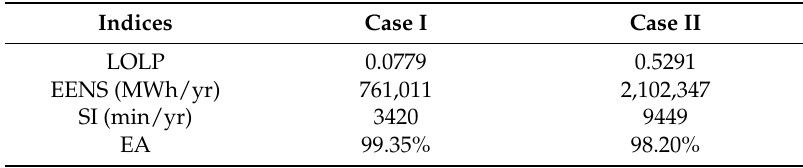
Table 6. Reliability indices of test grid with a different number of